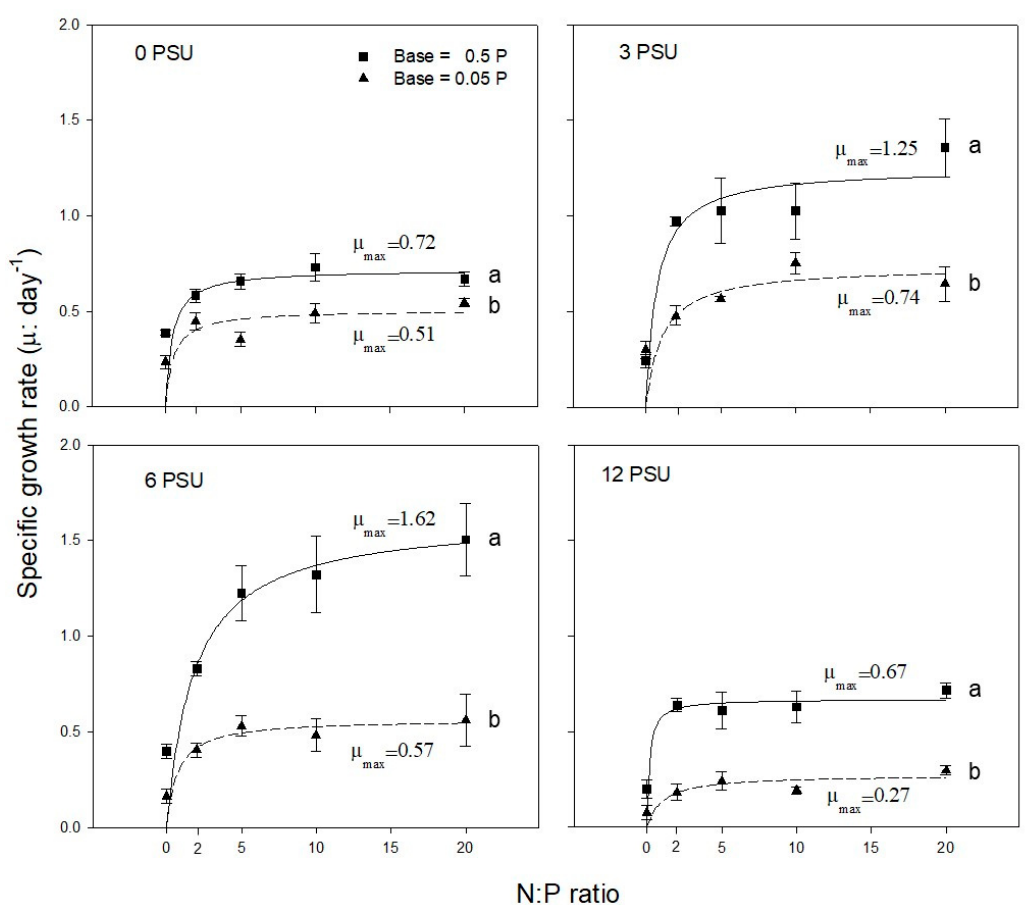
Figure 2. Variation in specific growth rate ( μ ) of S. quadricauda with increasing N:P ratio with two fixed P concentrations (0.05 and 0.5 mgP/L) at salinity levels of 0, 3, 6, and 12 psu. N concentration differs for the same N:P ratio because P concentration was fixed. Experimental conditions are presented in Table 1 (Exp. 2 and 3). Data are presented as averages with standard deviations (bars). Lower case letters on the right side indicate significant differences ( p < 0.05).